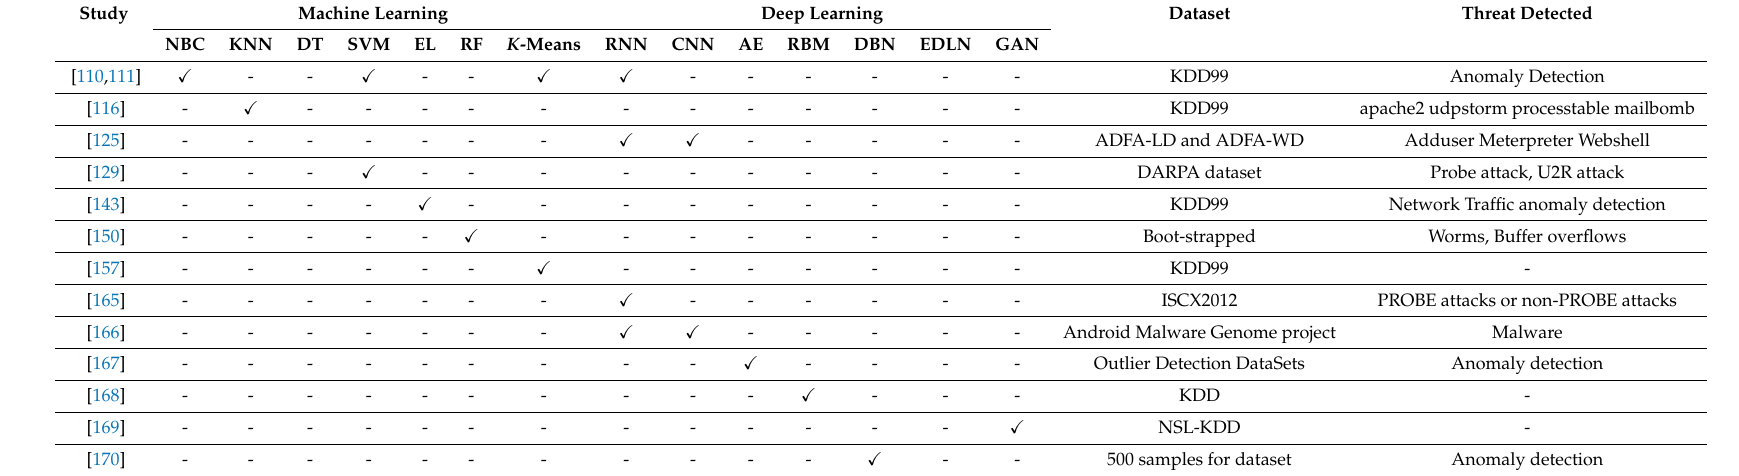
Table 5. Comparison of studies that used ML and DL techniques in IoT